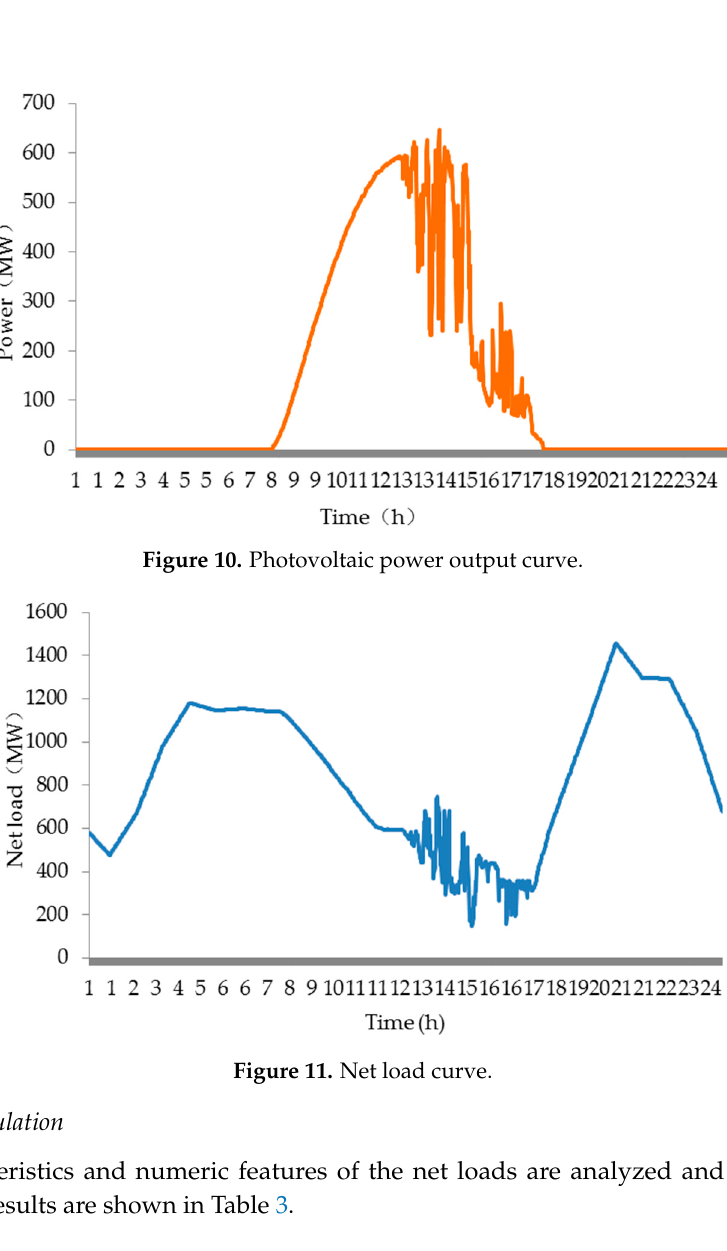
Table 3. Data for the SampEn of net load